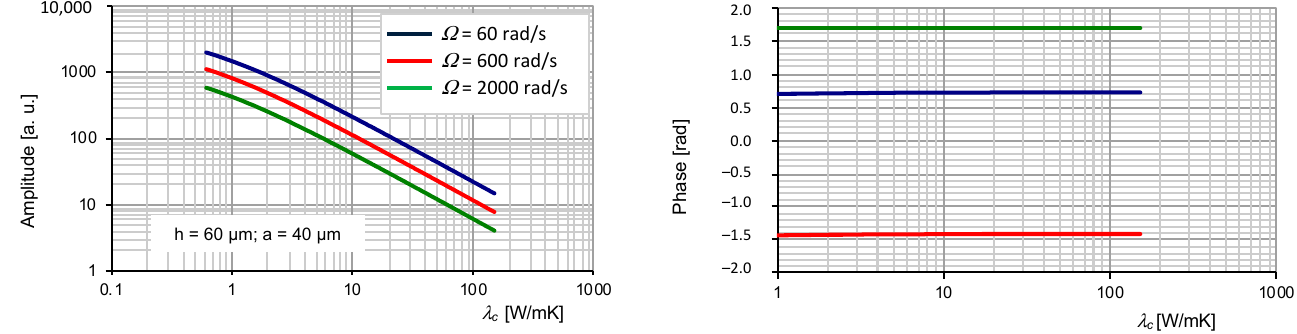
Figure 6. Theoretical BDS amplitude and phase dependence on the values of thermal conductivity of coating deposited on bulk support for PB height over the sample of 60 μ m and its radius in the waist of 40 μ m and for different modulation frequencies of the excitation beam (60, 600, 2000 rad/s). The amplitude of BDS signal decreases with the increase in the coating thermal the material’s ability to conduct heat. The higher the value, the higher the rate of heat at which the heat generated in the sample is transferred to the surrounding media by diffusion. Thus, the increase in thermal diffusivity value increases the BDS signal, as shown in Figure 7. The behavior of TO is determined by both values of thermal parameters describing their temporal and spatial